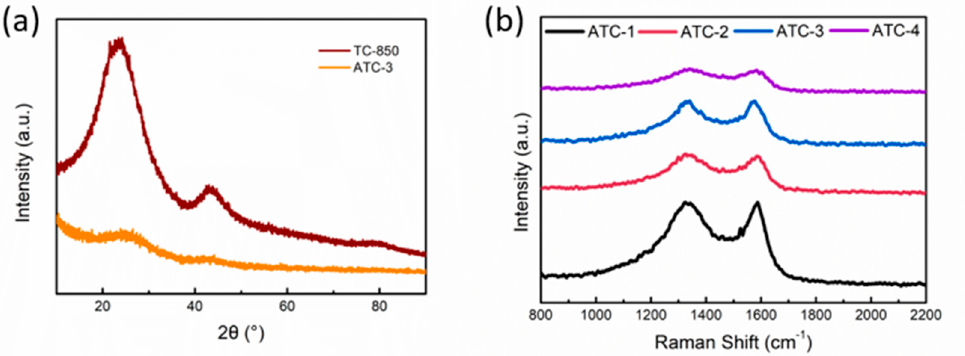
Figure 3. ( a ) XRD spectra of TC-850 and ATC-3; ( b ) Raman spectra of ATC-1/2/3/4.